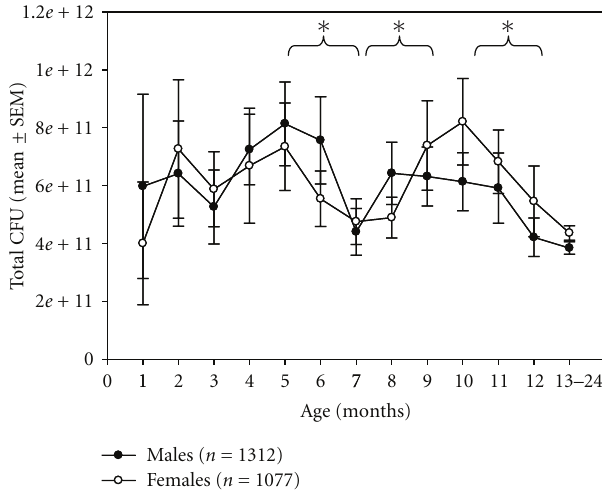
Figure 2: Total CFU (mean ± SEM) by age (months) and by gender. “ ∗ ” indicate significant di ff erence in post-hoc T -test (Bonferroni corrected). A number of boys and girls are infants (604 : 459 m : f) plus children up to 2